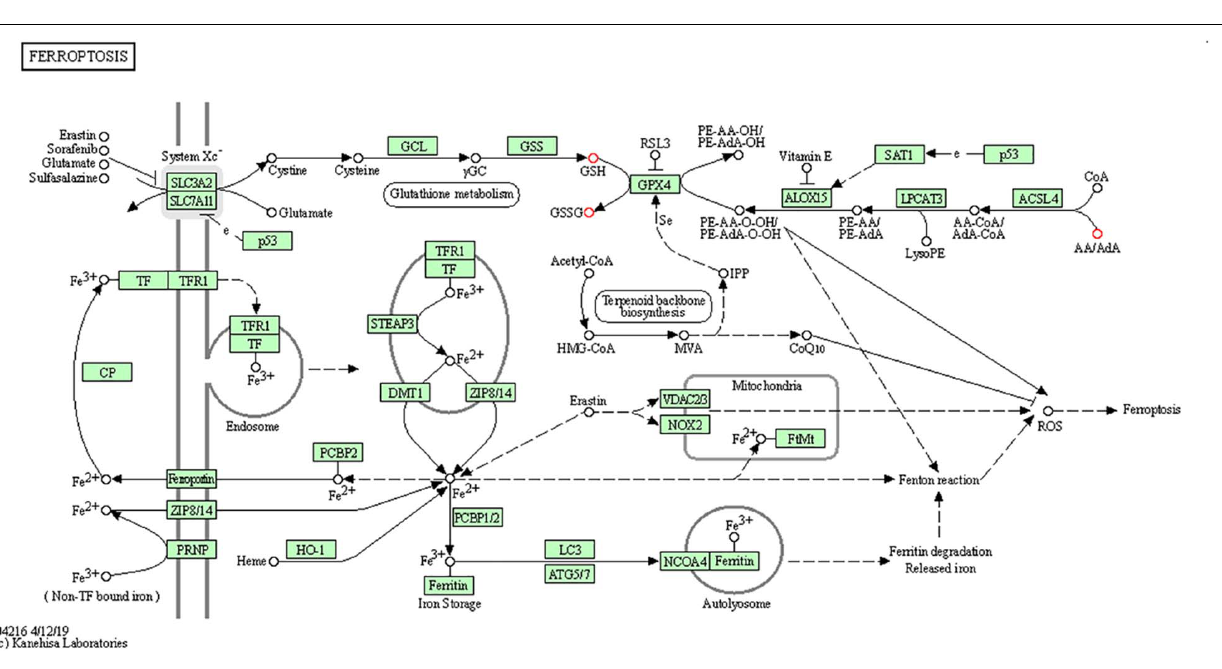
FIGURE 6 | The KEGG map of ferroptosis pathway The KEGG map shows metabolic, signaling, and molecular interaction networks. The red dot represents the differential